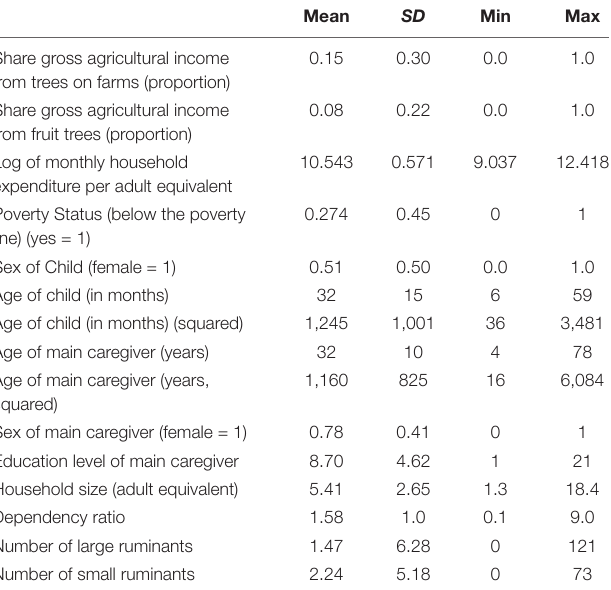
Mean SD Min Max 0.15 0.0